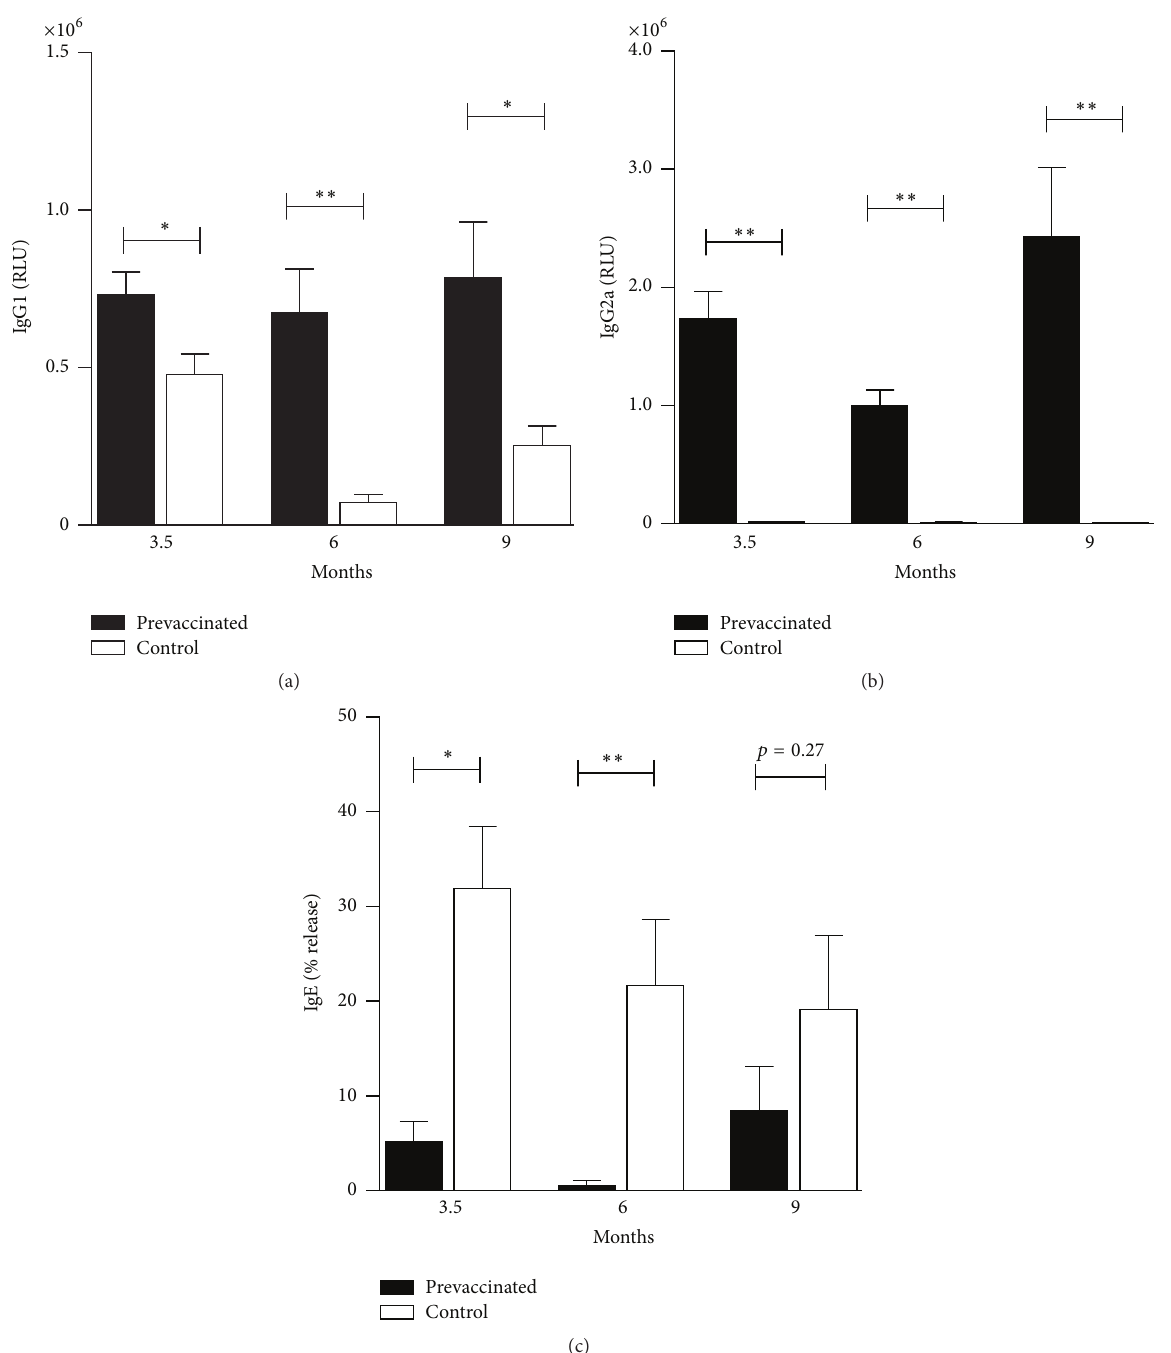
Figure 1: Phl p 5-specific IgG1 (a), IgG2a (b), and IgE (c) antibodies one week after sensitization. BALB/c mice were prevaccinated or left untreated and sensitized with recombinant Phl p 5 after the indicated time interval. Data are shown as relative light units of a luminometric ELISA or as percentage of total release induced by addition of 10% Triton X-100 and presented as means ± SEM ( 𝑛 = 5 ). ∗ 𝑝 < 0.05 ; ∗∗ 𝑝 < 0.01